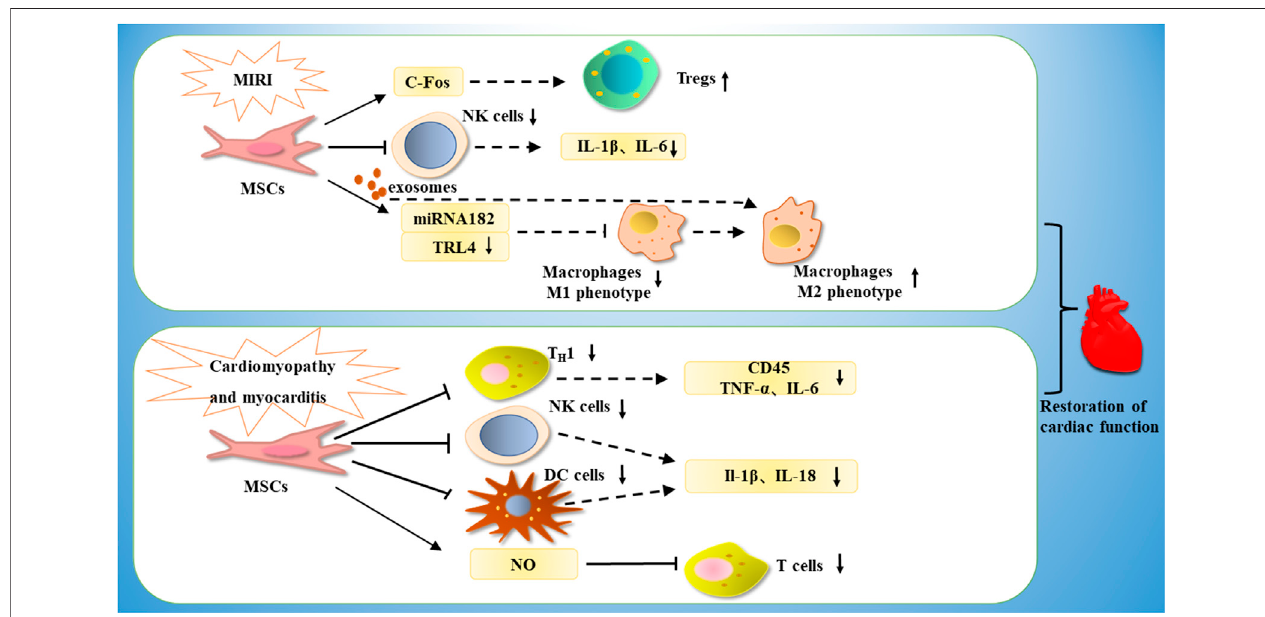
FIGURE 5 | MSCs are able to treat cardiomyopathy by increasing the number of Tregs through c-Fos, or by inhibiting NK cells, decreasing the expression of IL-1 β andIL-6,orbyreleasingmiRNA182-athroughexosomes,therebydownregulatingTRL4,inhibitingM1-typemacrophagesandpromotingphenotypicconversionofM1- type macrophages to M2-type macrophages. In the treatment of myocarditis, MSCs are able to exert immunomodulatory effects by downregulating Th1, thereby downregulating CD45, TNF- α , IL-6, or by inhibiting NK cells and DC cells, thereby downregulating IL-1 β and IL-18 expression, or by inhibiting T cell proliferation through